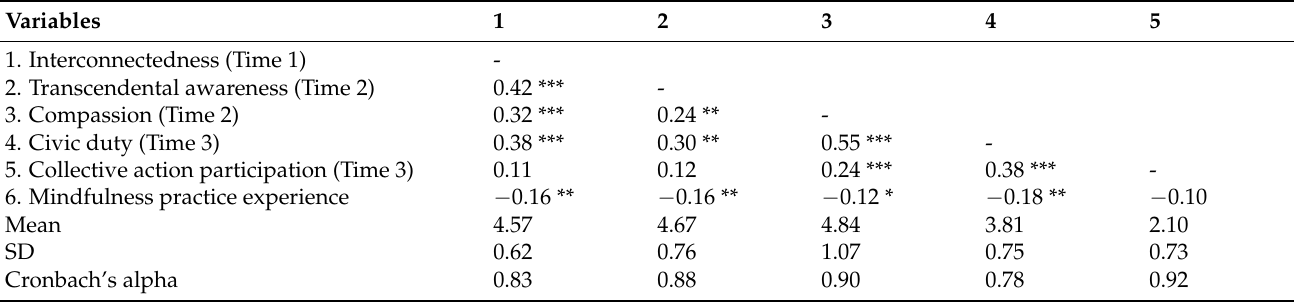
Table 1. Descriptive statistics and correlations of the study